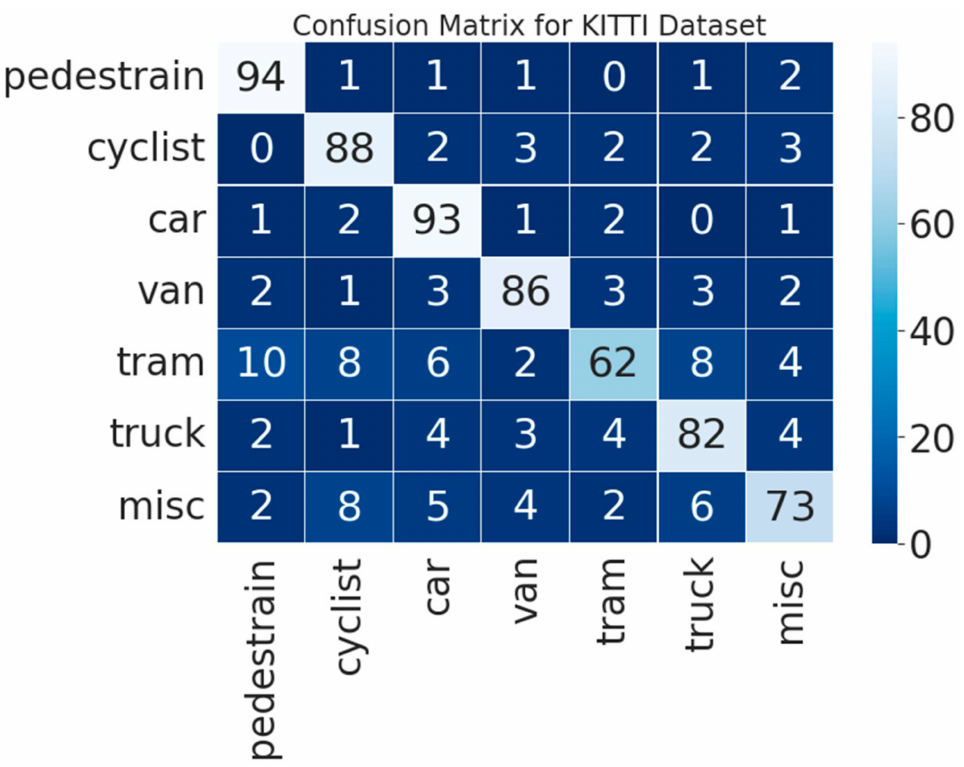
Figure 11. Confusion matrix of 7 classes on the KITTI database via